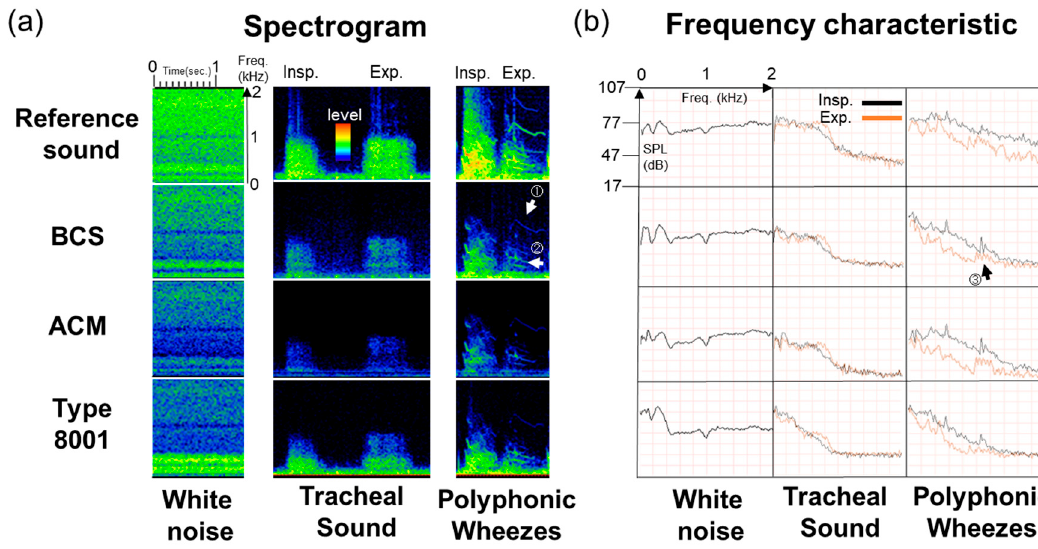
Figure 8. Observation experiment using a respiratory sound simulator. ( a ) Spectrograms and ( b ) Frequency responses of white noise, tracheal sound, and polyphonic wheezes.